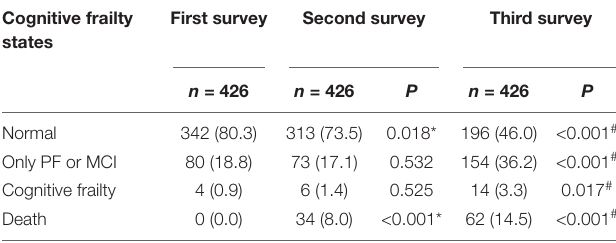
TABLE 2 | Characteristics of participants who did or did not complete three visits. TABLE 3 | The rates of different cognitive frailty states in three